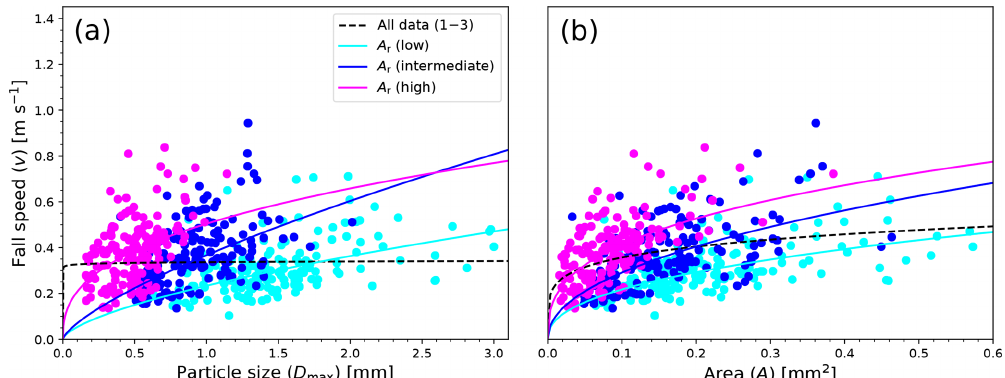
Figure 12. Fall speed vs. particle size (a) and fall speed vs. cross-sectional area (b) relationships for the combination of shape groups (1) Needles , (2) Crossed needles , and (3) Thick columns . Fits that apply to binned data ( M b ; see Sect. 3.2.2) are shown for all the data (solid black line) and for different A r (low, intermediate, and high) ranges. All data, in this case, only include particles in these three shape groups, i.e., (1–3) . Same data are shown in Table 5. Table 5. Fall speed vs. particle size ( v vs. D max ) and fall speed vs. cross-sectional area ( v vs. A ) relationships fitted to binned data ( M b ) for the combination of particles in shape groups (1) Needles , (2) Crossed needles , and (3) Thick columns with different area ratio A r ranges (low, intermediate, and high). The number of particles, N , the parameters a D , b D , a A , b A , and their respective uncertainties, and the correlation coefficients R 2 are shown. All data are also shown. In this case, all data include only particles in these three shape groups, i.e., (1–3) . b v vs. D max v vs. A Ranges N a D [ms − 1 ] b D R 2 a A [ms − 1 ] b A R 2 D A All data (1–3) 486 0.34 ± 0.04 0.01 ± 0.07 0.01 0.50 ± 0.10